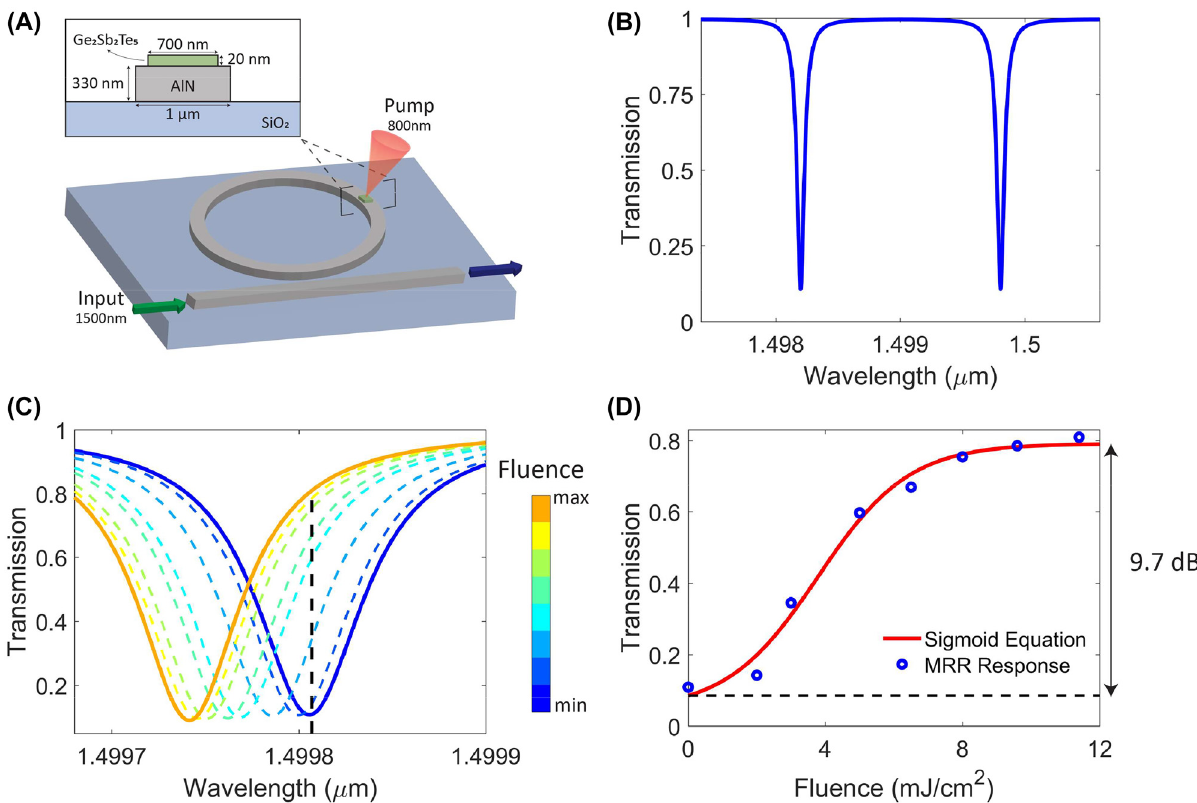
Figure4: Ge 2 Sb 2 Te 5 -basedMRRNLAF.(A)SchematicdiagramofMRRwiththecorrespondingdimensions.SpectralresponseoftheGe 2 Sb 2 Te 5 - basedMRRNLAFwhenitis(B)unperturbedand(C)excitedwithvariousfemtosecondlaser fl uencepulses.(D)Resultingsigmoidfunctionused to implement the NLAF. The transmission values of the blue data points intersect with the black dotted line in